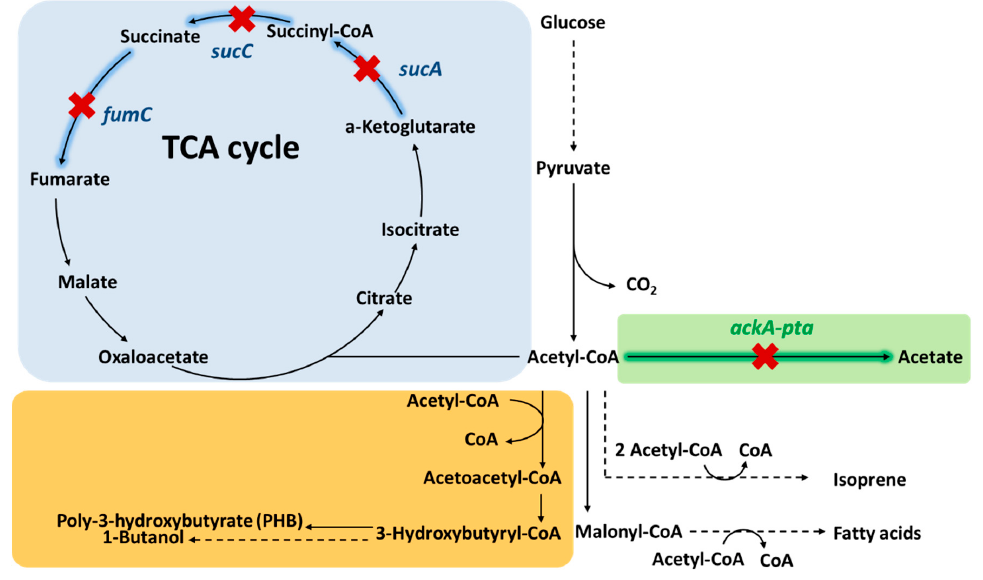
Figure 3. Genes inhibited to decrease acetyl-CoA consumption. Since acetate is a byproduct synthesized by E. coli under both aerobic and anaerobic condition, the acetate formation genes, ackA and pta , were frequently deleted to avoid the consumption of acetyl-CoA to acetate. ack and pta encode the enzyme of acetyl-CoA kinase and phosphate acetyltransferase, respectively. In addition, acetyl-CoA is consumed significantly by TCA cycle aerobically. Therefore, the deletion of sucA , encoding for α -ketoglutarate dehydrogenase, sucC , encoding for succinyl-CoA synthetase and fumC , encoding for fumarase, were also used for increasing acetyl-CoA concentration. The orange shadowed area represents the CoA-dependent pathway for 1-butanol and poly-3-hydroxybutyrate (PHB) synthesis, whose production improved by applying the deletion of acetyl-CoA consuming pathways. Dashed arrows indicate multi-step reactions.